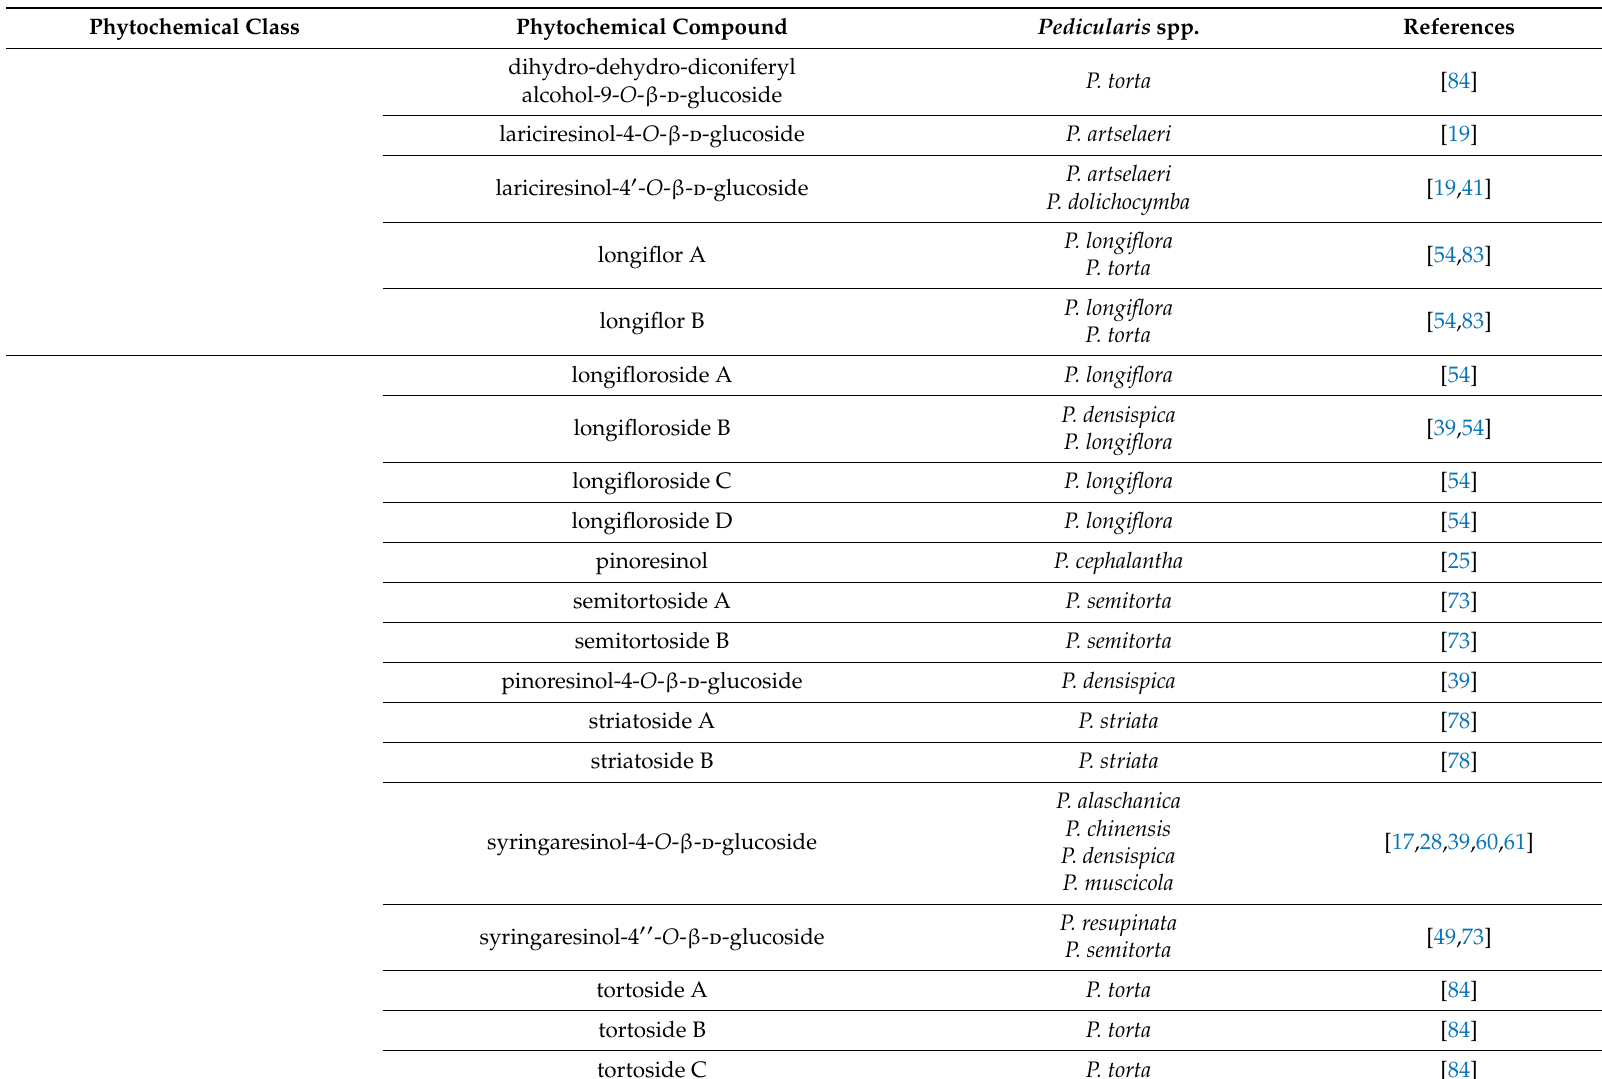
Phytochemical Class Phytochemical Compound Pedicularis